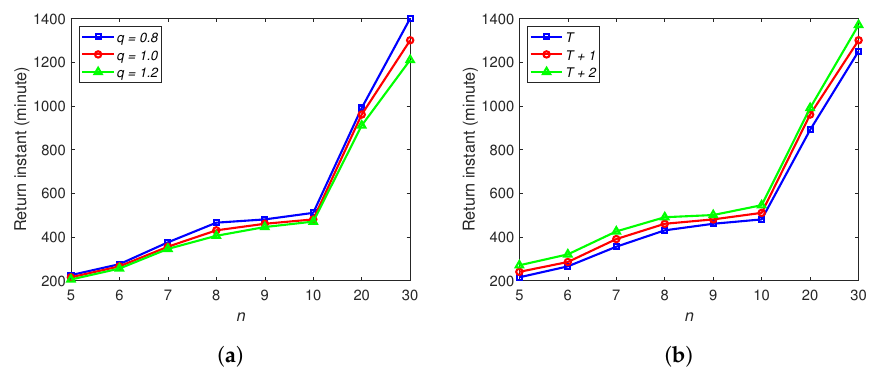
Figure 8. ( a ) The influence of q . ( b ) The influence of T